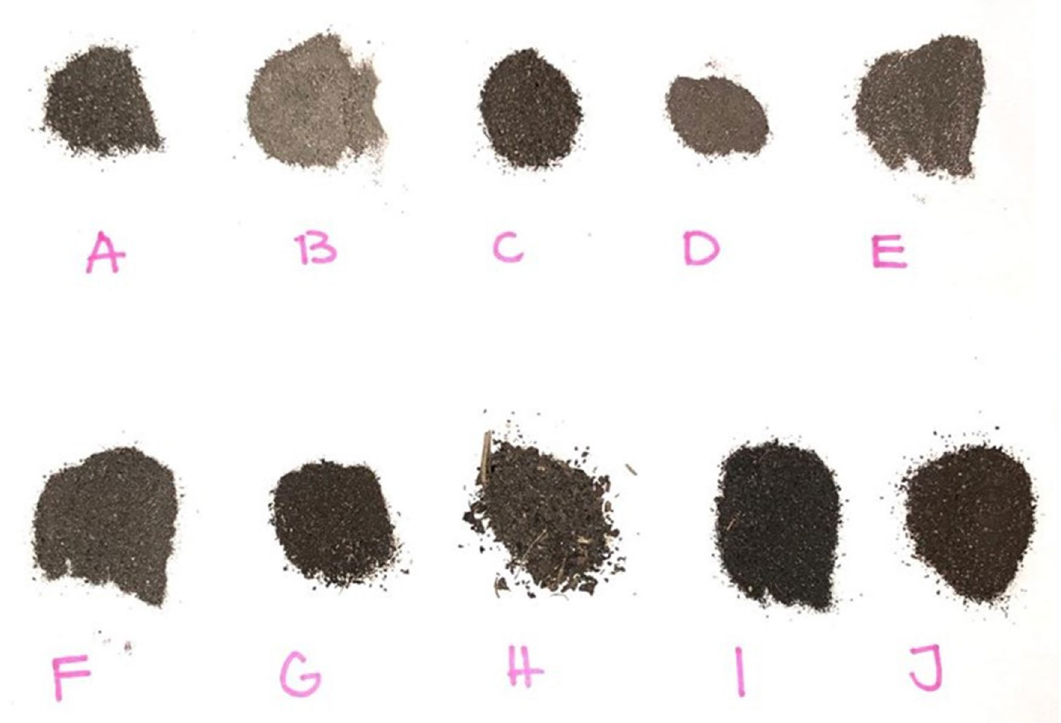
Figure 1. Dry color photograph of the soils in the study (particle size ≈ 2